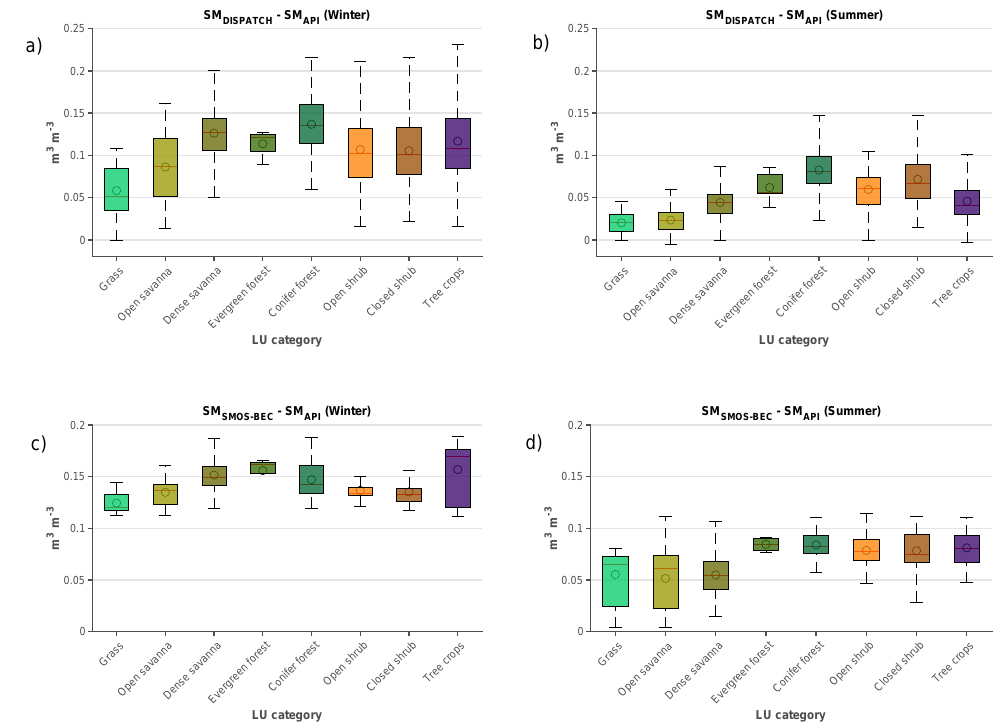
Figure 3. Soil moisture (SM) difference between Disaggregation based on Physical And Theoretical scale Change (DISPATCH) ( a , b ) or SMOS-Barcelona Expert Center (SMOS-BEC) ( c , d ) and antecedent precipitation index (API) (that is, the bias of the satellite-based soil moisture (SBSM) products is represented with respect to the modelled). The results are presented for different land use (LU) categories in the region of analysis shown in Figure 1. The boxplots provide information about the mean (circle marker), the median (red line), the 50% of the central distribution of the data (central black box) and the rest (whiskers) calculated using the mean SM biases during the winter ( a , c ) and summer ( b , d ). Colours correspond to the legend of LU categories in Figure 1. The absolute values provided should not been taken into account since the in situ and the satellite time series have not been rescaled for that aim. Only the differences between the LU categories should be